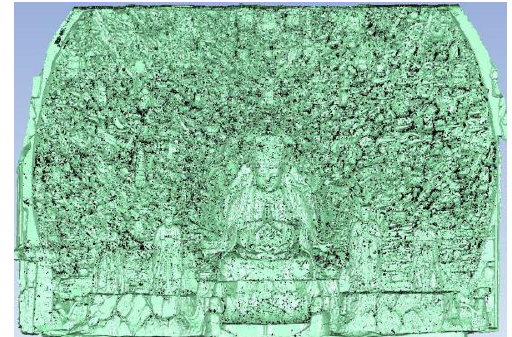
Figure 3. The 3D Cloud Data of The Dazu Thousand-hand Bodhisattva Statue